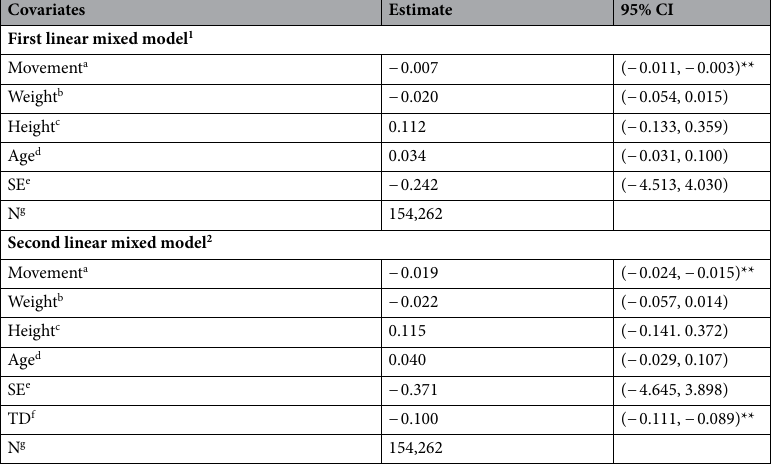
Table 2. Relationships of movement, weight, height, age, sleep efficiency with glucose rate of change (%) in pregnancy, unadjusted and adjusted for time of day (95% CI) from linear mixed effects models. Regression coefficients are given by the 1st quartile unit increases for movement, weight, height, age and sleep efficiency. The 1 st quartiles: Movement = 1.6 mg . Weight = 66 kg. Height = 1.63 m. Age = 27.9 years. Sleep efficiency =